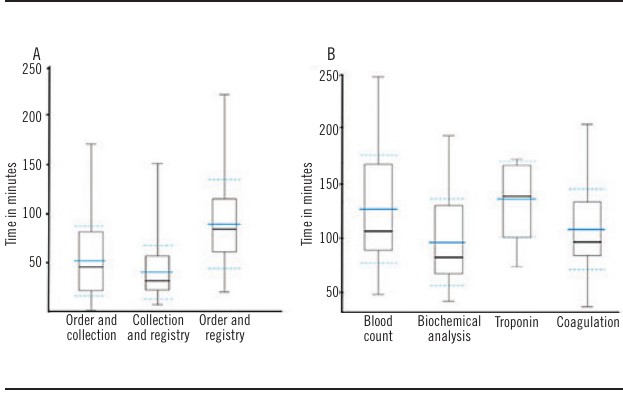
FigurE 1 − Time involved in the different steps of laboratory process A) time of steps in the pre-analytical phase; B) time between specimen collection and result release. The blue continuous and dotted lines represent mean and standard deviation, respectively; the black lines, median; the error bars, minimum and maximum